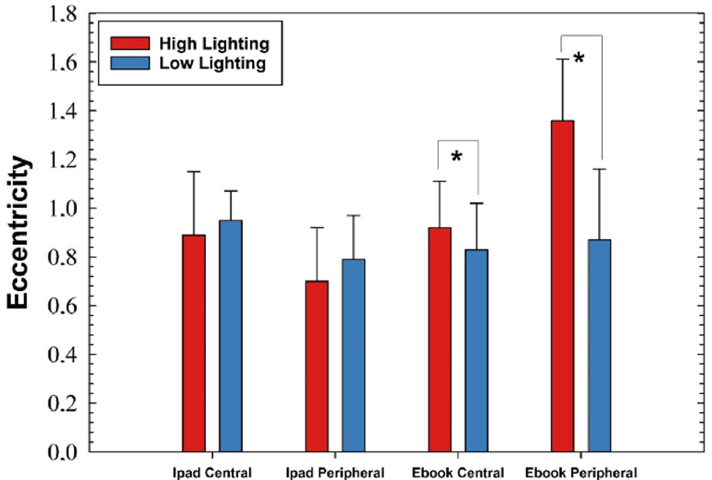
tion to a parabolic shape in both central and peripheral locations.